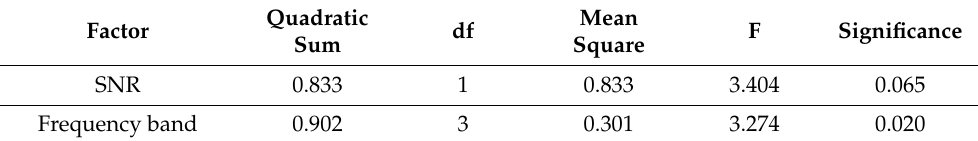
Table 3. The ANOVA analysis of impact factors.